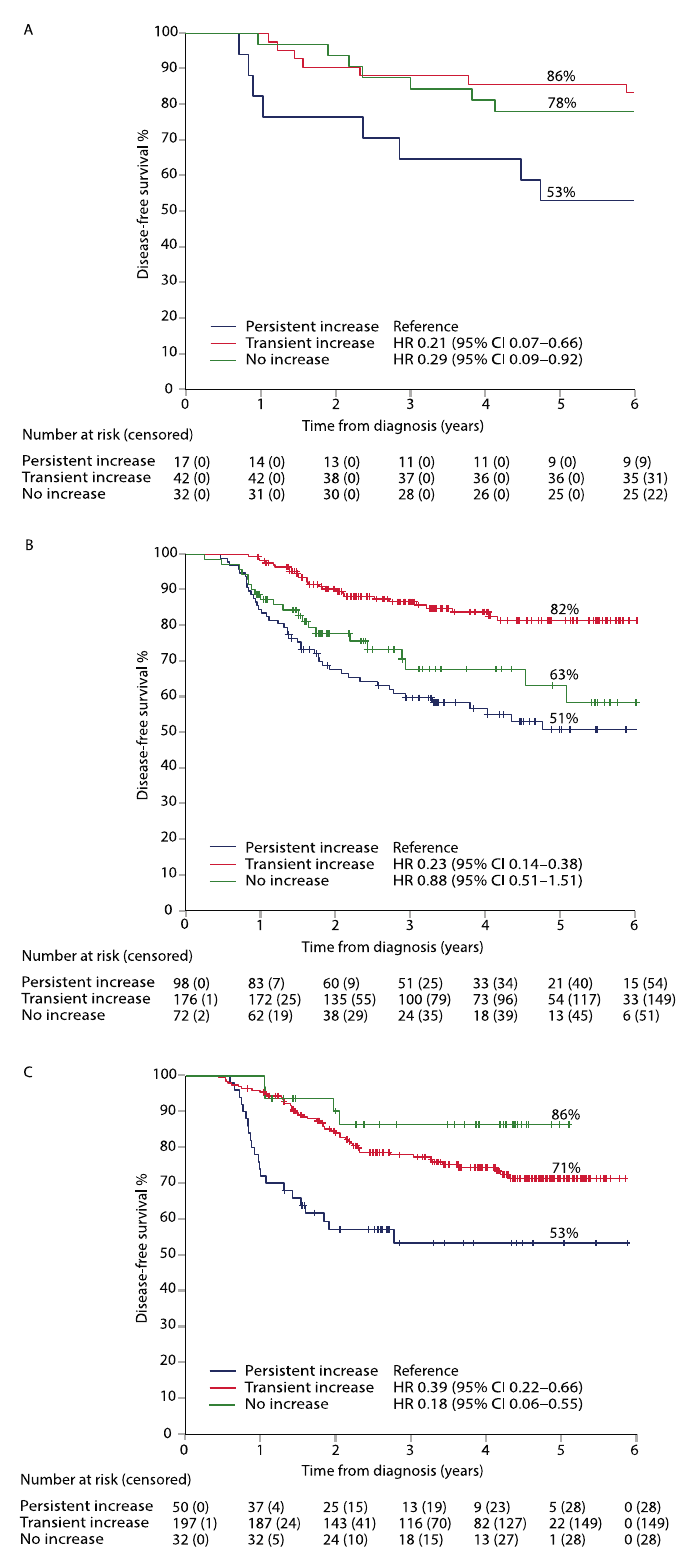
Figure 1. Disease-free survival (DFS) in the LIPSYT study (panel ( A )), TAUH (panel ( B )), and TUH (panel ( C )) cohorts, according to CEA dynamics within reference during adjuvant therapy.